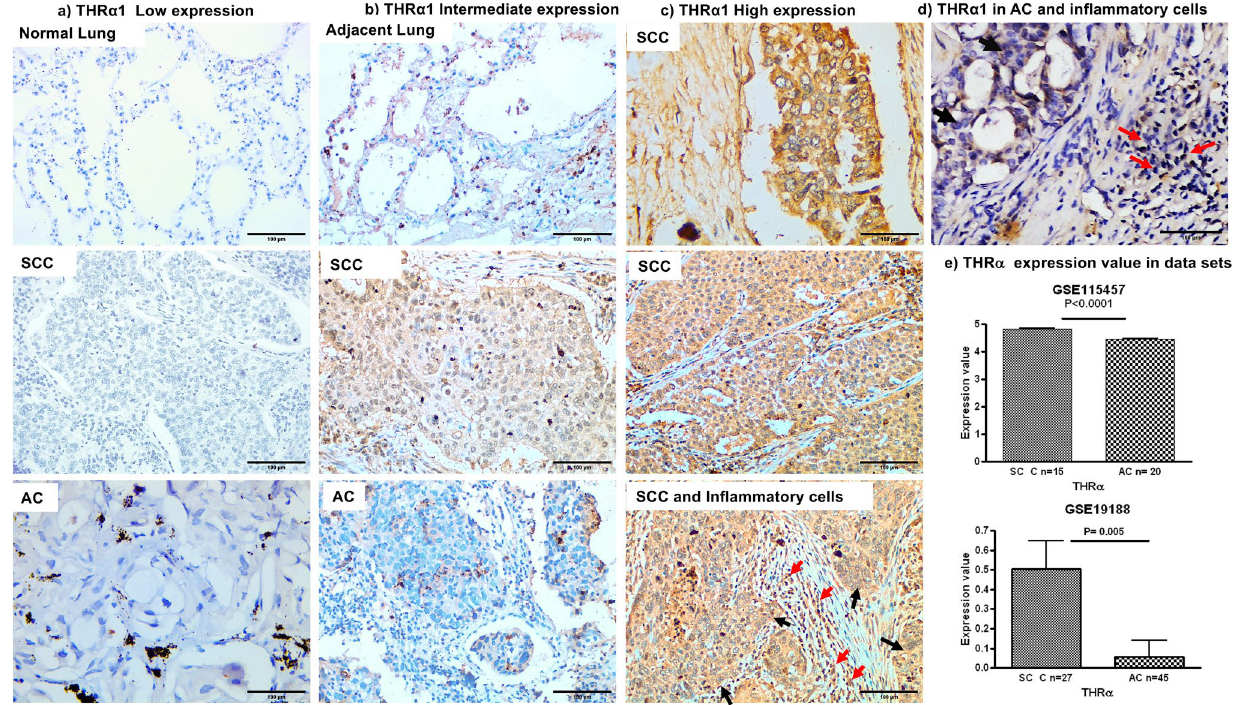
Figure 1. THRα1 protein expression in human NSCLC tissues and gene expression in GEO data sets. ( a ) low THRα1 protein expression in normal lung tissue, SCC, and AC. ( b ) Intermediate THRα1 protein expression in adjacent lung tissue, in SCC and in AC. ( c ) High THRα1 protein expression in most SCC tumour cells and associated inflammatory cells. ( d ) Low THRα1 protein expression in AC tumour cells, no THRα1 protein expression in associated inflammatory cells. Magnification 200x, scale bar 100 µm, black arrows pointed to tumour cells and red arrows to inflammatory cells. ( e ) THRα mRNA expression levels in data sets showing significant high expression in SCC compared to